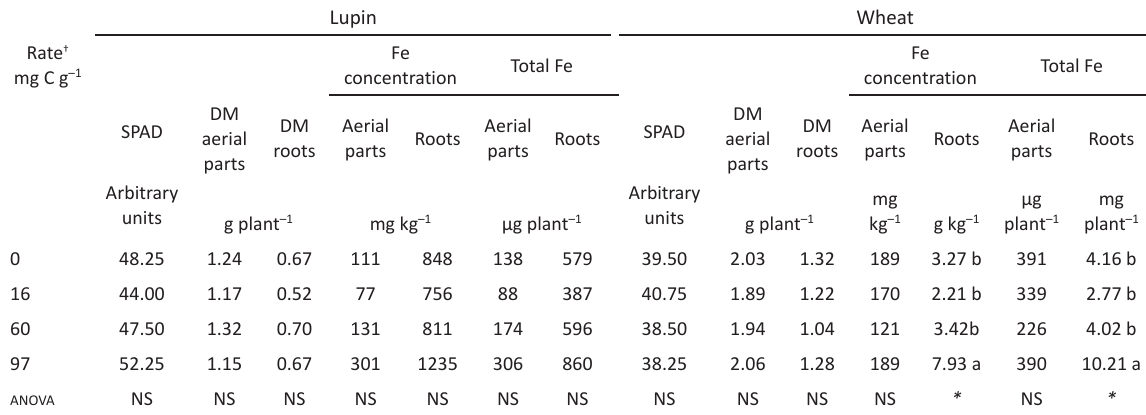
Fig. 1. Effect of the different rate of Fe-HS on total Fe uptake by lupin (black columns) and wheat (grey columns). One-way ANOVA was performed for each plant independently. Means with different letter were significantly different as per LSD test at p < 0.05; Error bars indicate one standard error.